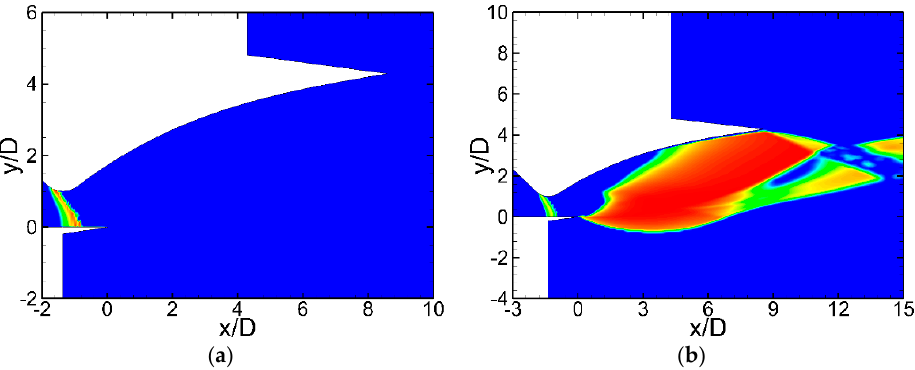
Figure 9. Typical contours of nucleation rate in wet steam flow. ( a ) p 0 = 7 bar, T 0 = 465 K; and ( b ) p 0 = 32 bar, T 0 = 527 K.